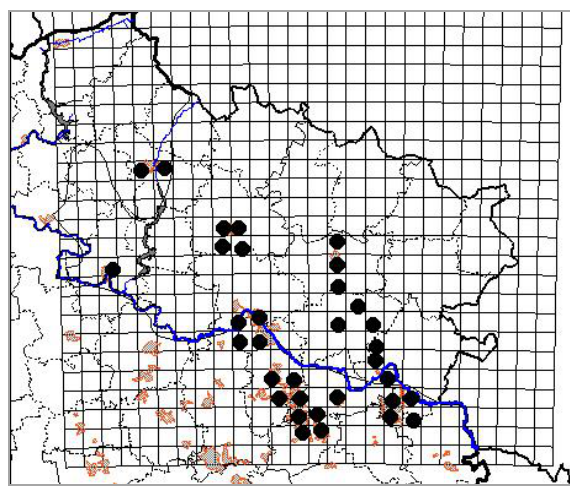
Fig. 24. The map of the distribution of Robinia pseudoacacia L. in the Starobilsk grass-meadow steppe